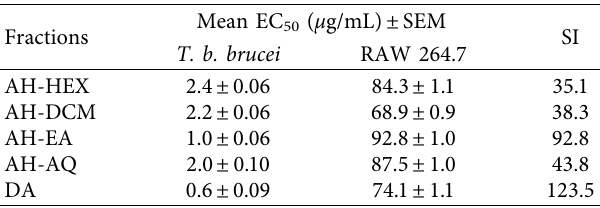
SI (selectivity index) was estimated as the ratio of the EC 50 value in RAW 264.7 cell lines to the EC 50 value in T. b. brucei . High SI values denote greater selectivity towards T. b. brucei in the presence of RAW 264.7 cell lines. Standard errors of the mean (SEM) were calculated from quadru- plicate sets of EC 50 values. Hexane fraction � AH-HEX, dichloromethane fraction � AH-DCM, ethyl-acetate fraction � AH-EA, aqueous frac- tion � AH-AQ, DA � Diminazene